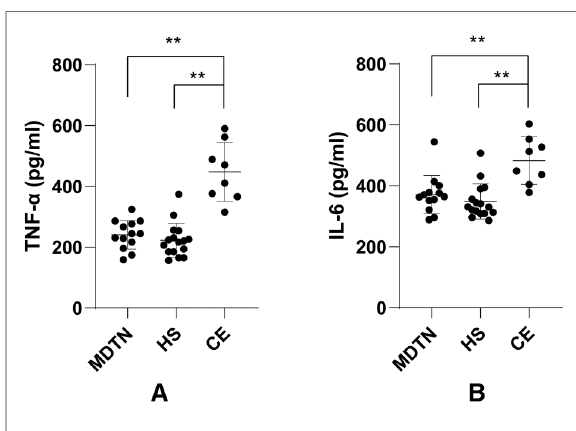
FIGURE 2 Comparison of early-stage in fl ammatory factors in the drainage fl uid from the three groups. ( A ) TNF- α levels in the drainage fl uid; ( B ) IL-6 levels in the drainage fl uid. ** P